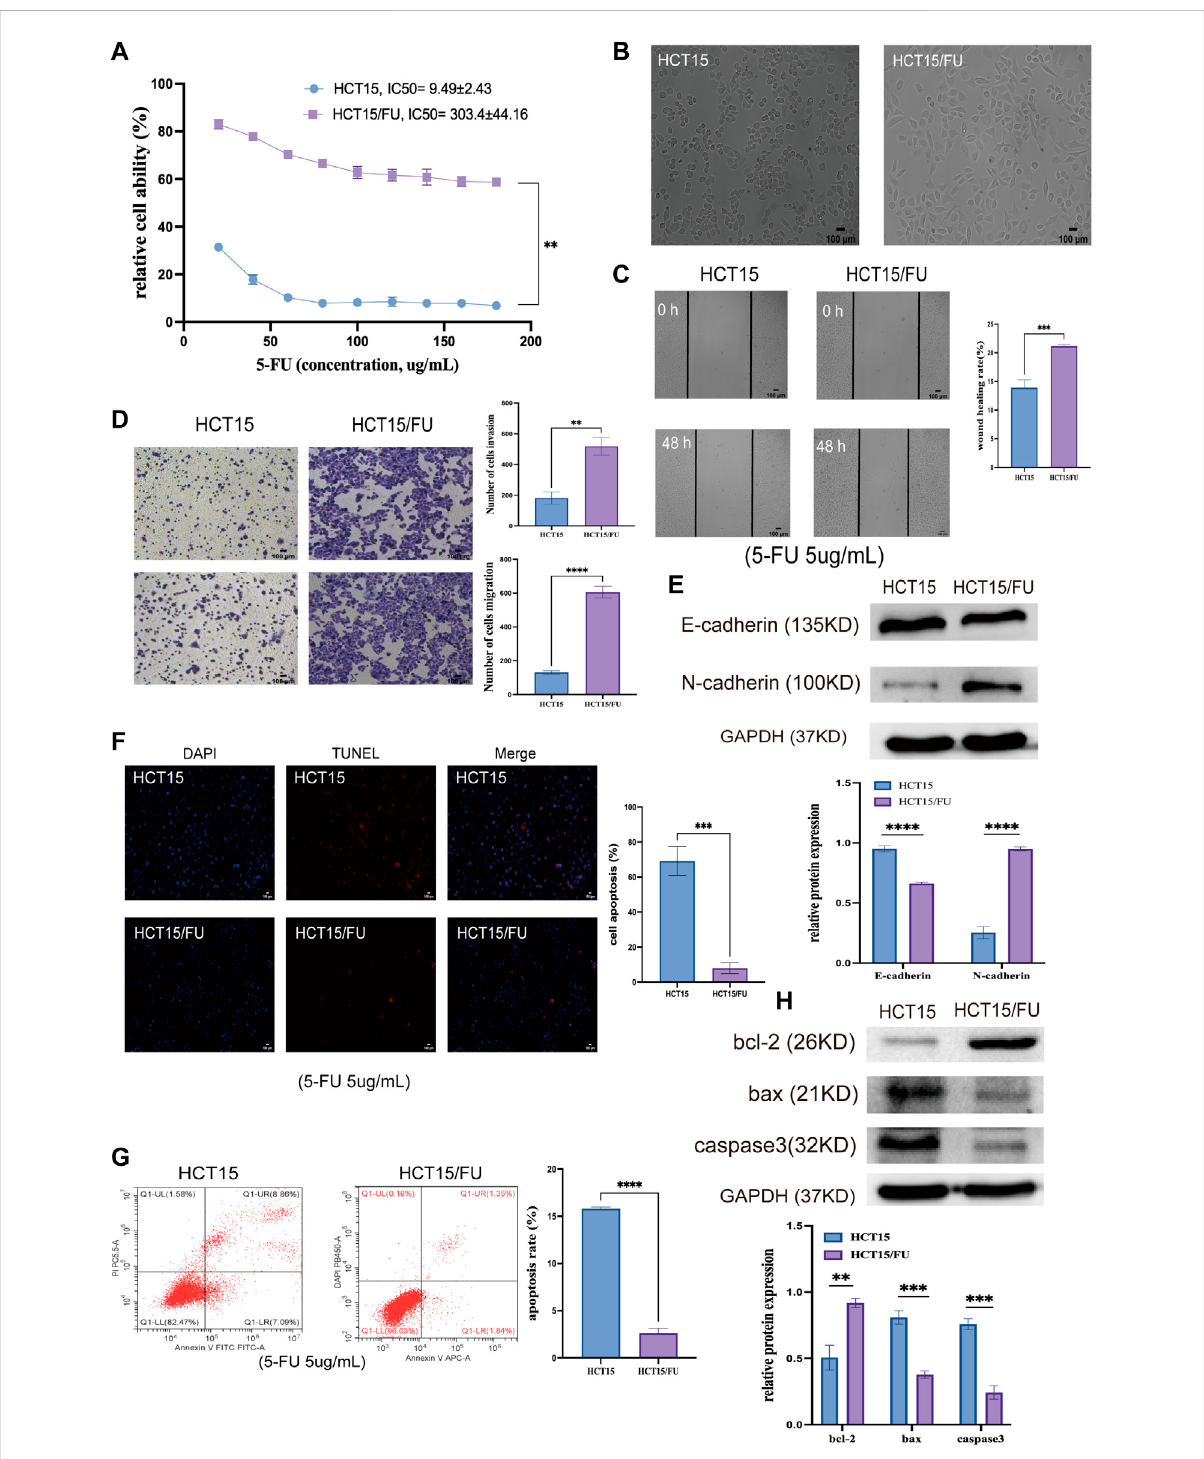
FIGURE 3 5-FU-resistant CRC cells exhibit EMT induction and apoptosis-resistant phenotypes. (A) CCK-8 assays were used to compute IC50 and resistance index (RI) values for HCT15 and HCT15/FU cells. (B) HCT15 and HCT15/FU cell morphological characteristics were visualized. (C,D) Transwell and wound healing experiments investigated these cells ’ relative migratory and invasive activity. (E) Both HCT15 and HCT15/FU cells have EMT-related protein levels. (F,G) TUNEL staining and fl ow cytometry were employed to examine the apoptotic death of HCT15 and HCT15/FU cells. (H) Apoptosis-associated protein expression was detected in HCT15/FU cells. Data are represented as means ± SD (** p < 0.01, *** p < 0.001, **** p <